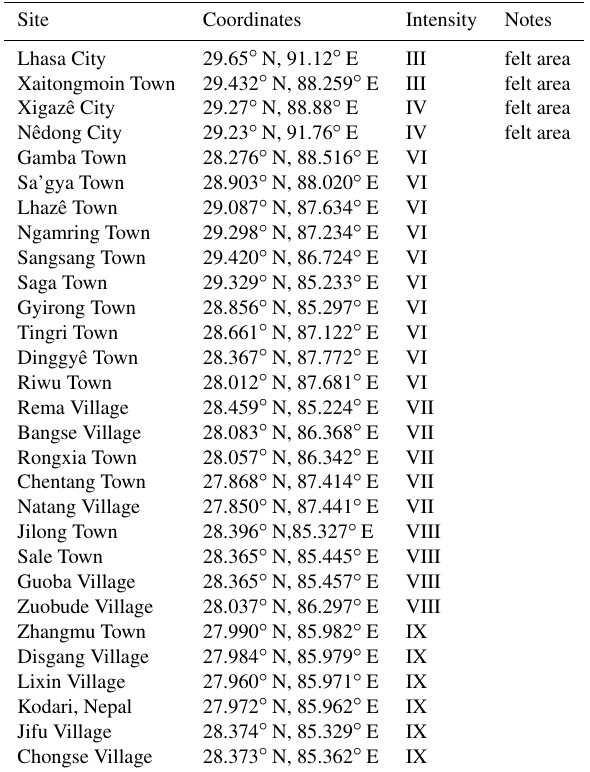
Table 1. Location of surveyed sites of earthquake intensity in south- ern Tibet. The .kmz file for these sites and some photos of typical housing damage are given in the